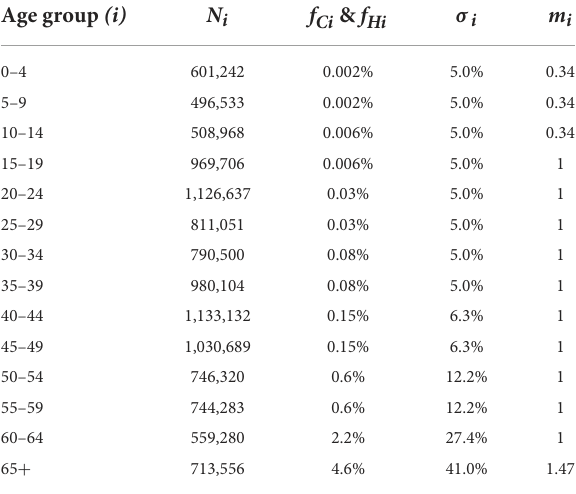
TABLE 2 Values of N i , f i , σ i , and m i of different age